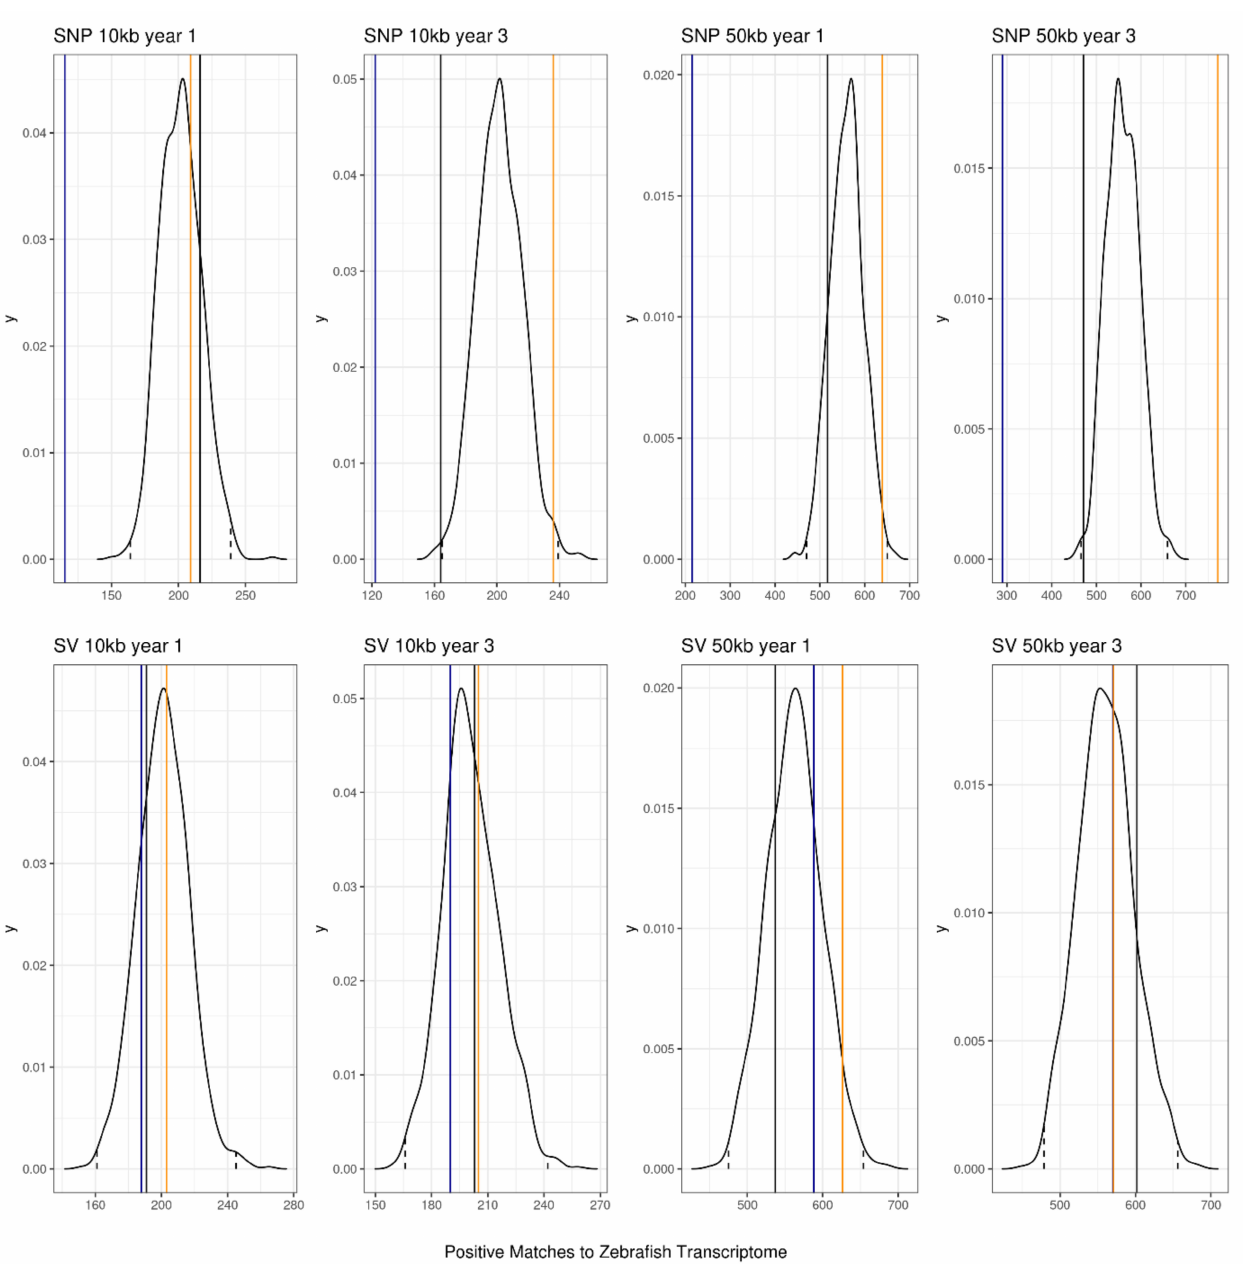
Figure 7. Permutation test of top 200 features compared to sampling 200 features randomly across the genomic windows. Solid lines are the number of positive hits to a genomic annotation of zebrafish (black is ReliefF feature selection, blue is mutual information feature selection, and orange is Chi-square feature selection). Dotted lines are the 99% confidence intervals for the 1000 sets of 200 randomly sampled